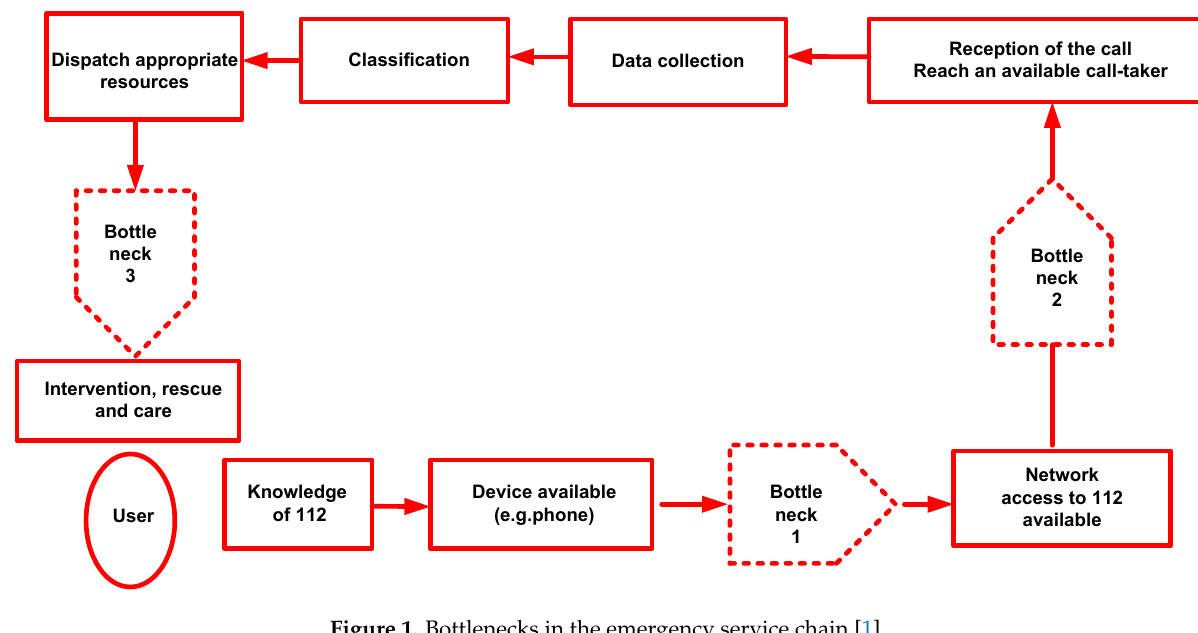
Figure 1. Bottlenecks in the emergency service chain